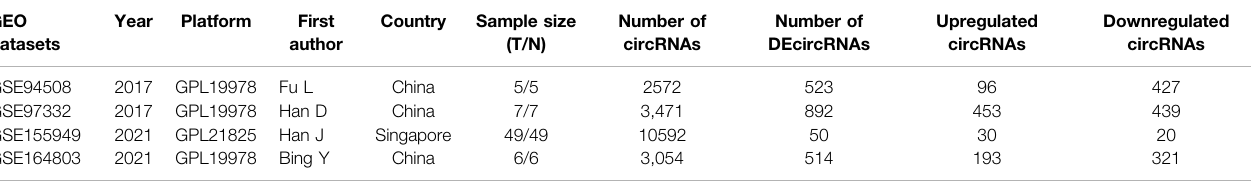
TABLE 2 | The detailed information of the four circRNA microarray datasets from GEO